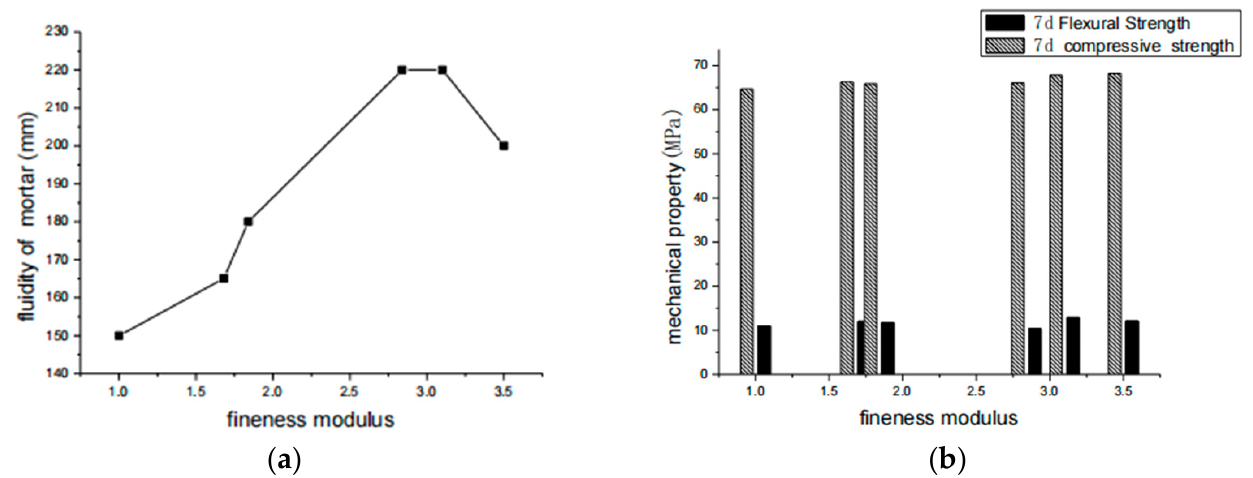
Figure 12. ( a ) Effect of fineness modulus on Fluidity. ( b ) The Mechanical Properties of Mortar. Reprinted with permission from ref. [63]. Copyright 2017